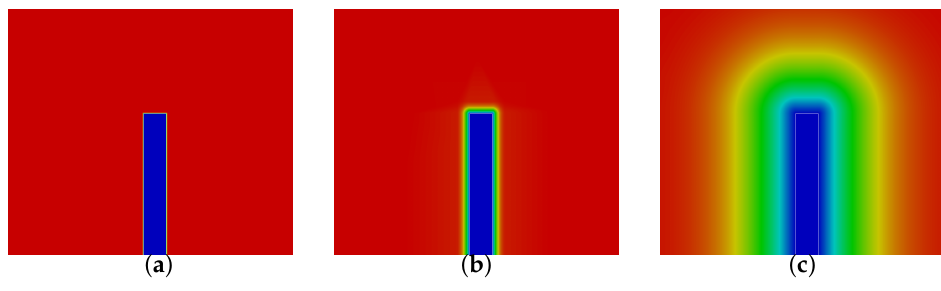
Figure 8. Interface function for ( a ) E = 0.1, ( b ) E = 1 and ( c ) E =